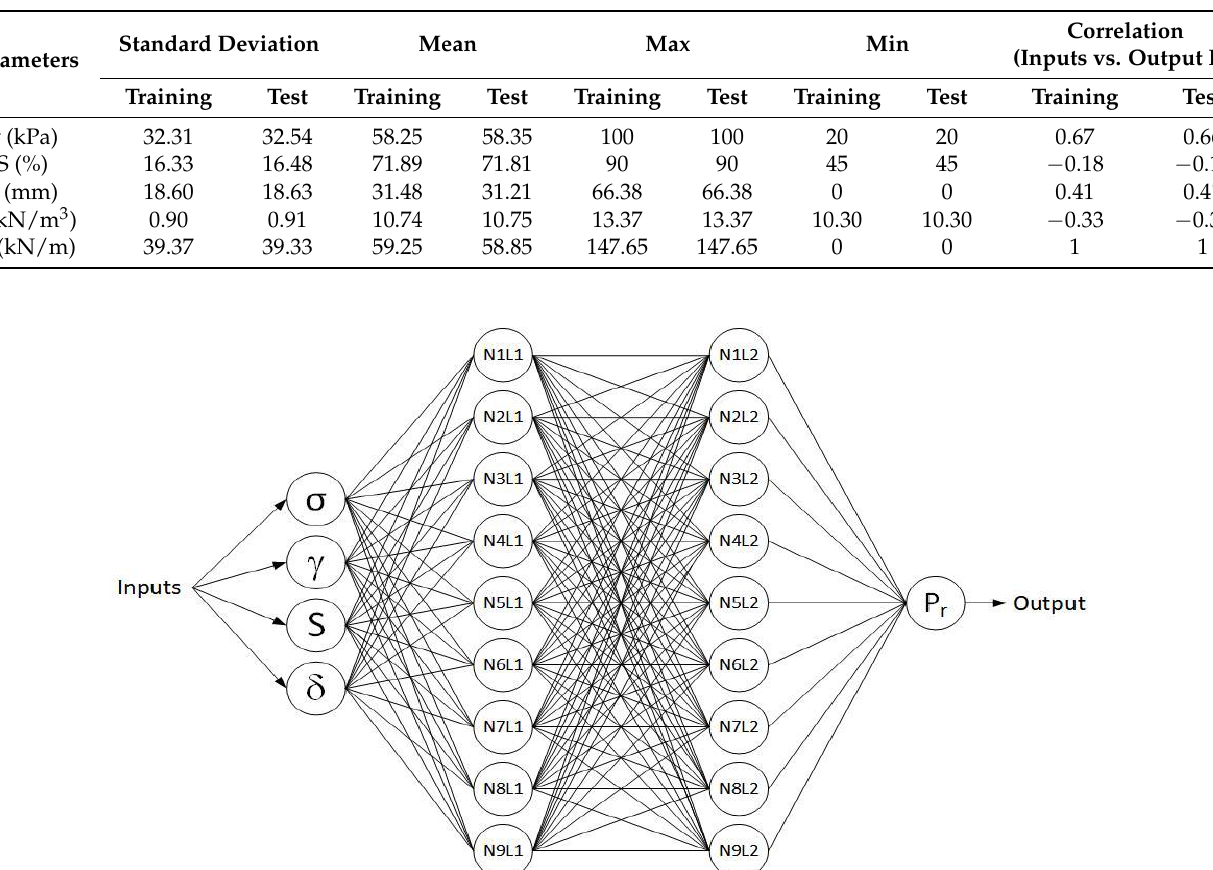
Figure 3. The machine learning architecture database consists of 61,775 measurements. Table 2. The statistical properties of the data.